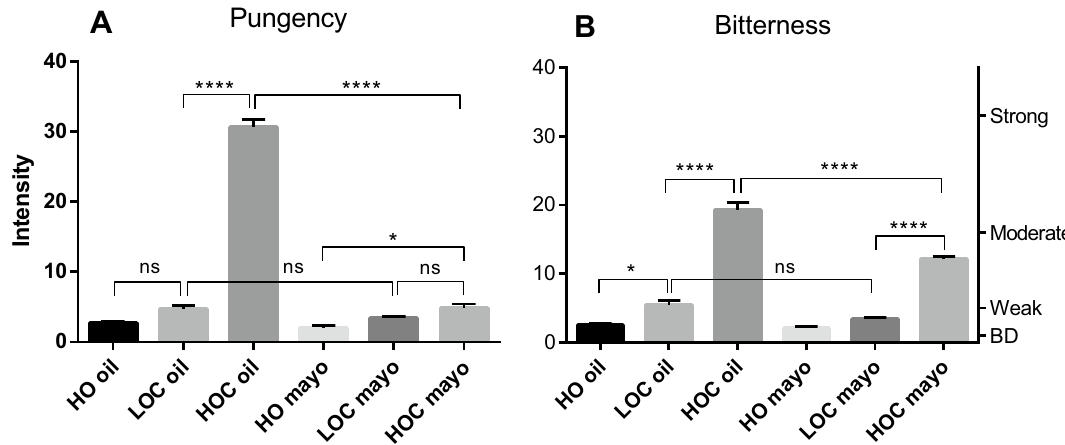
Figure 2. Comparison of perceived throat pungency ( A ) and bitterness ( B ) from 3 oils: HO (High Oleic acid Safflower oil), LOC (EVOO low in OC) and HOC (EVOO high in OC), and from 3 model mayonnaises made with the corresponding oils and 8 g egg yolk/100 g oil. The right axis displays the corresponding portion of the LMS scale used by participants to provide their ratings (BD = barely detectable). 10 subjects (3 females and 7 males; average age 28) rated each sample 4 times in random order. Data are represented as mean + /- SEM. Statistics: ns = not significant; * p < 0.05; ** p < 0.005; *** p < 0.001; **** p <